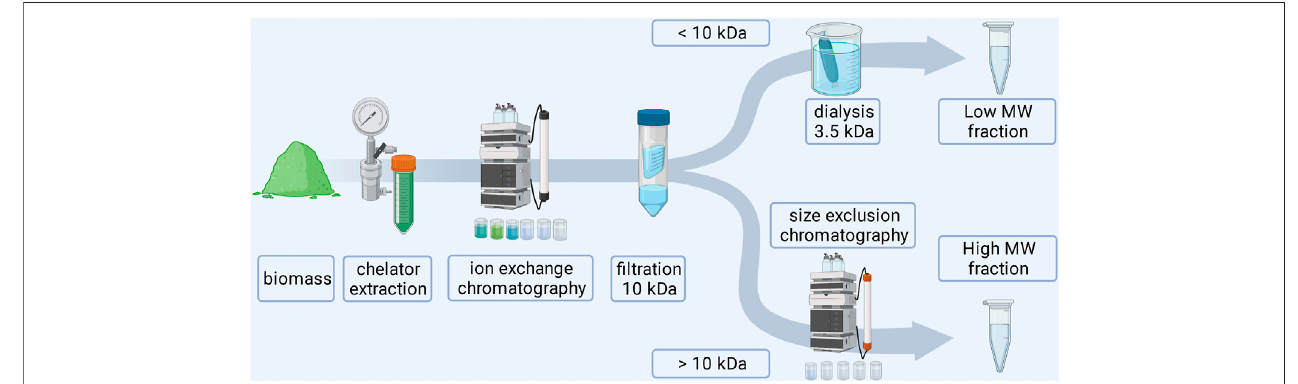
FIGURE 2 | Schematic work fl ow for the extraction of biomass derived chelators.